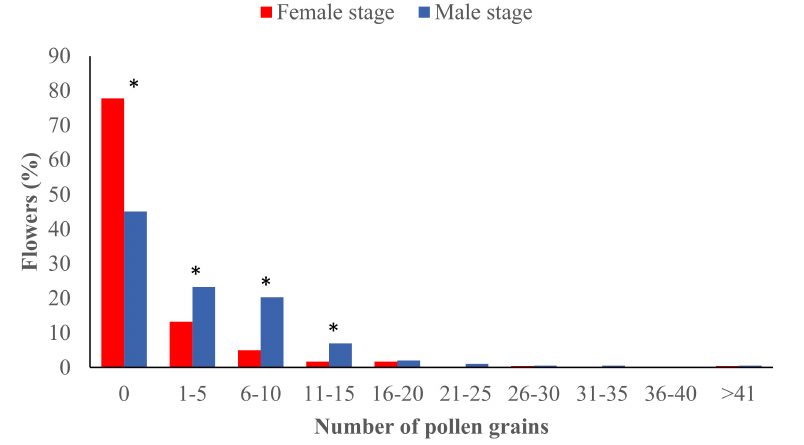
Figure 1. Percentage of flowers at the male and female stages left to open pollination with different pollen load sizes (number of pollen grains) on the stigma during the avocado flowering season. An asterisk into each range of the number of pollen grains indicates significant differences ( p < 0.05) between percentages of flowers at the female and male stages (Chi-square